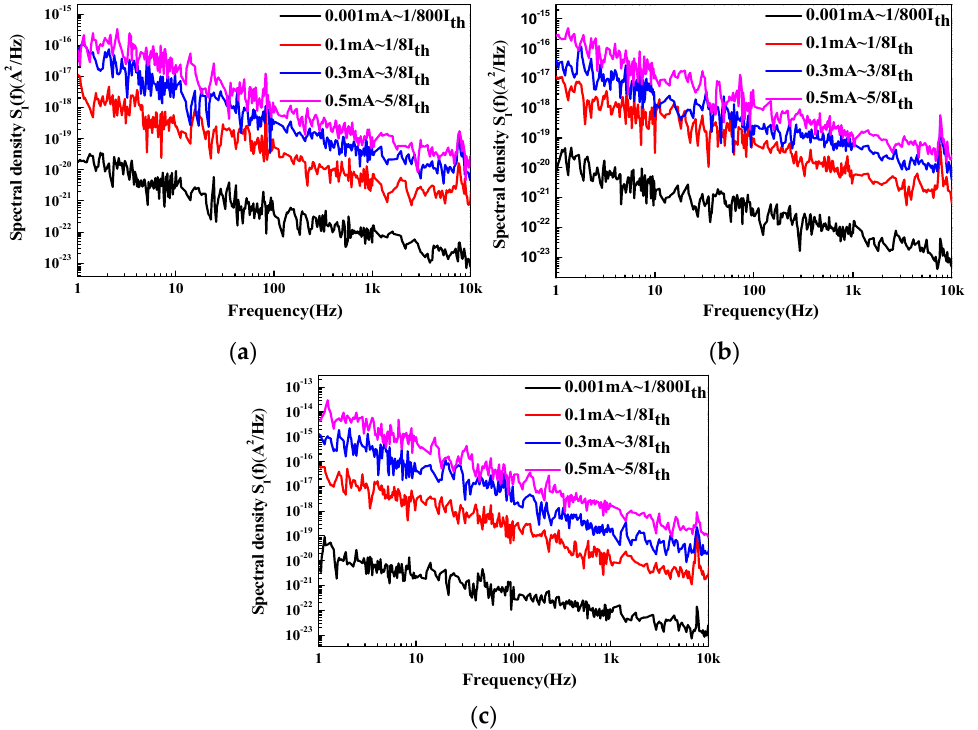
Figure 4. The current noise power spectral density curve of VCSELs versus frequency for different bias currents, ( a ) after 4000 h aging at 6 mA, ( b ) after 4000 h aging at 8 mA and ( c ) after 2500 h aging at 10 mA. Table 2. The frequency index factor and noise amplitude at different bias currents.